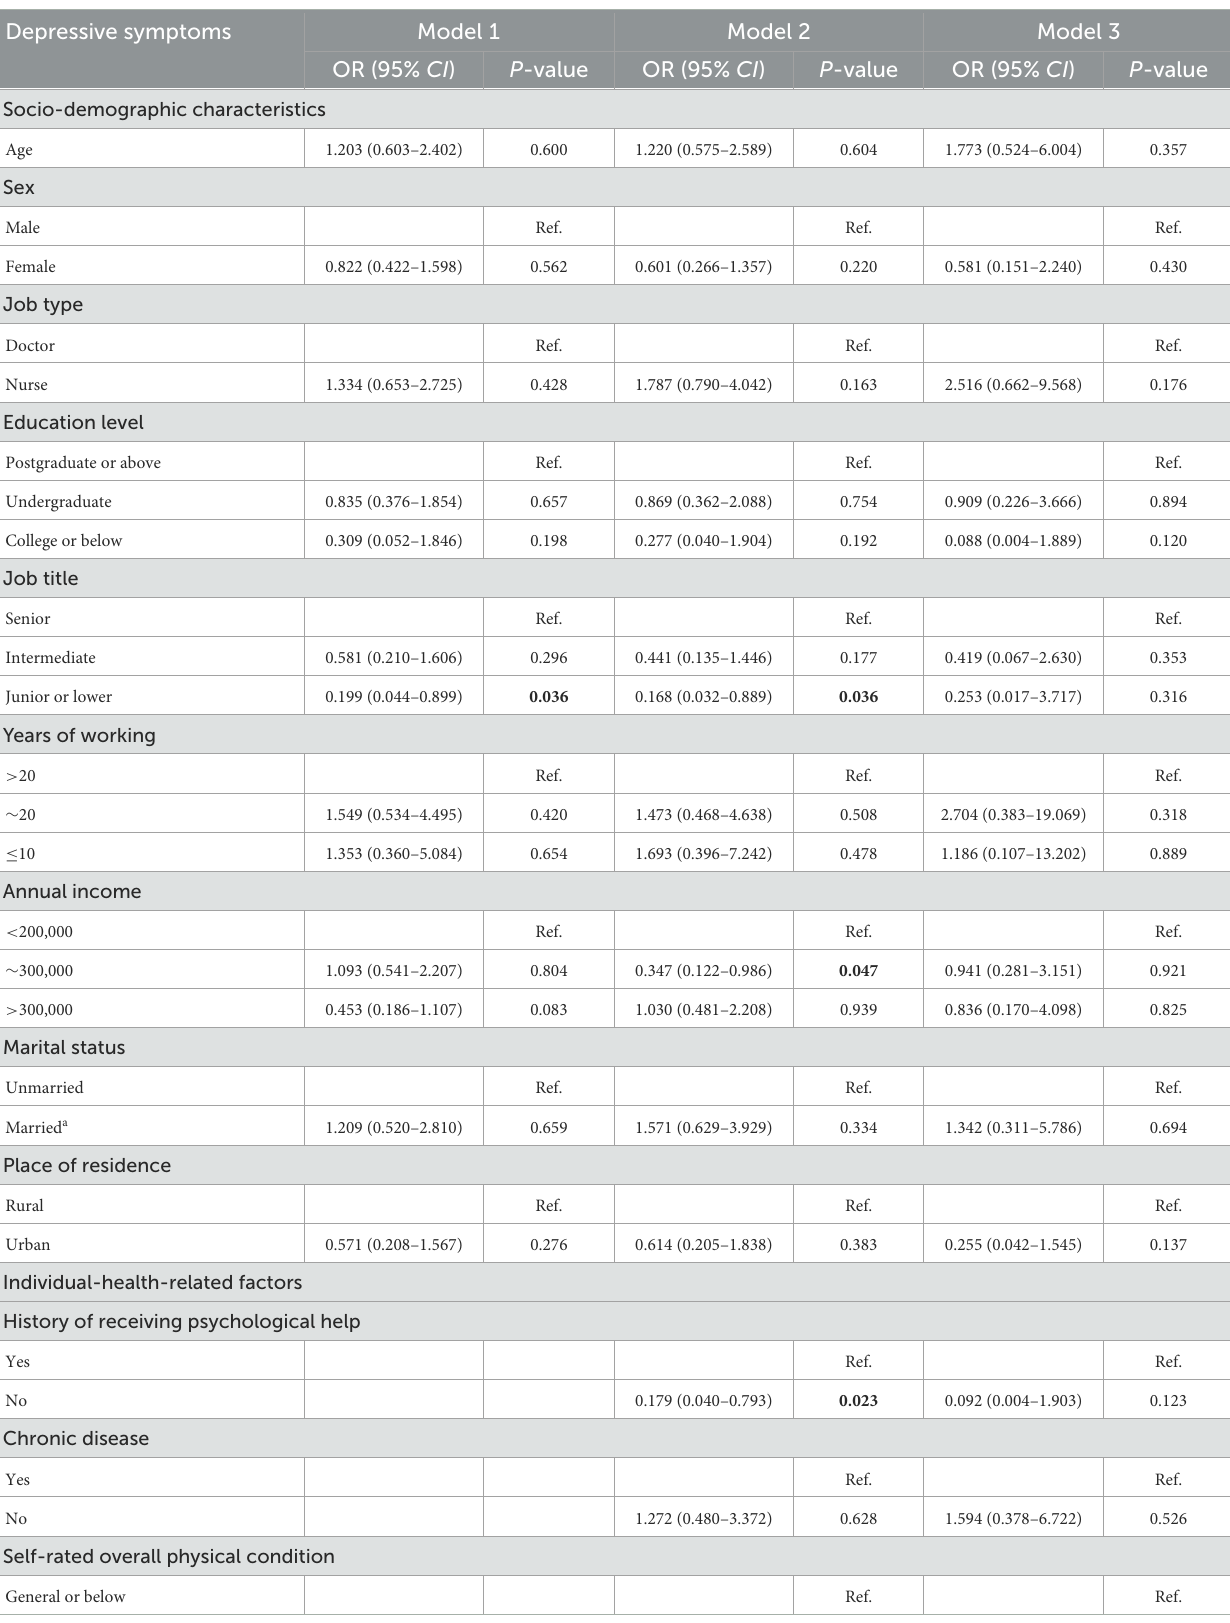
TABLE 2 Logistic regression analysis of depressive symptoms in the